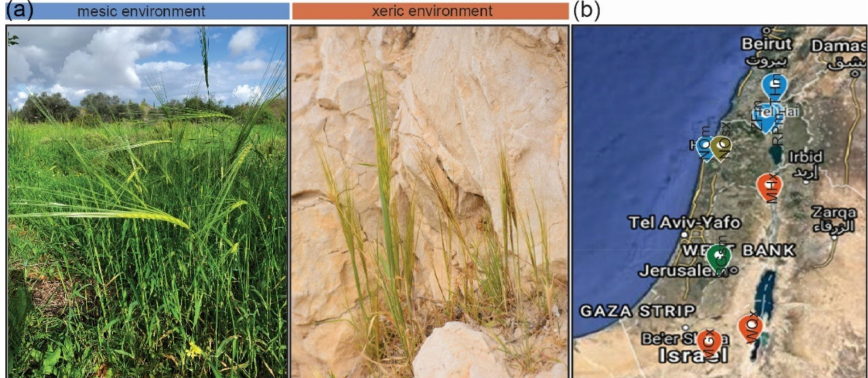
Figure 1. Geographic origin of wild barley ( H. vulgare subsp. spontaneum ) accessions. ( a ) Examples of wild barley from the Galilee (mesic) and Judean desert (xeric) in Israel. ( b ) Collection sites in Israel. Blue points = mesic sites (THm = Tel Hai, ZFm = Zefat, RPm = Rosh Pinna, NOm = Nahal Oren northern facing slope); green point = semi-mesic site (BGsm = Bar Giyyora); green-brown point = semi-xeric site (NOsx = Nahal Oren southern facing slope); orange points = xeric sites (MHx = Mehola, MGx = Machtesh Gadol, WQx = Wadi Qilt). The map was generated using Google Maps. Detailed ecogeographical data are presented in Table